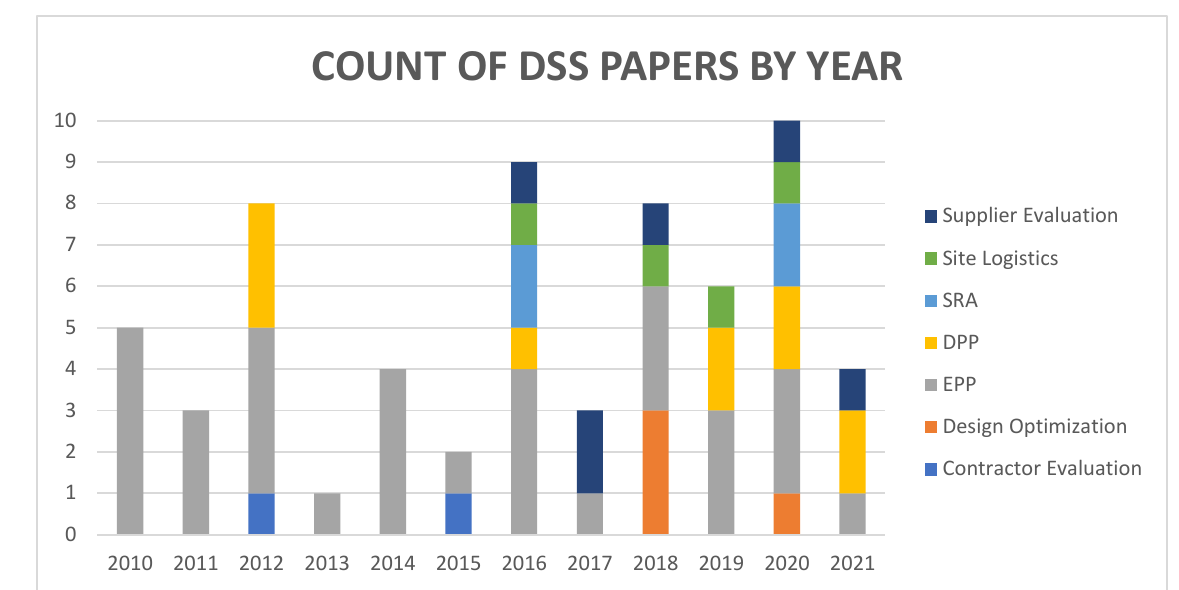
Figure 4. The count of each DSS category examined in papers by year of publication.